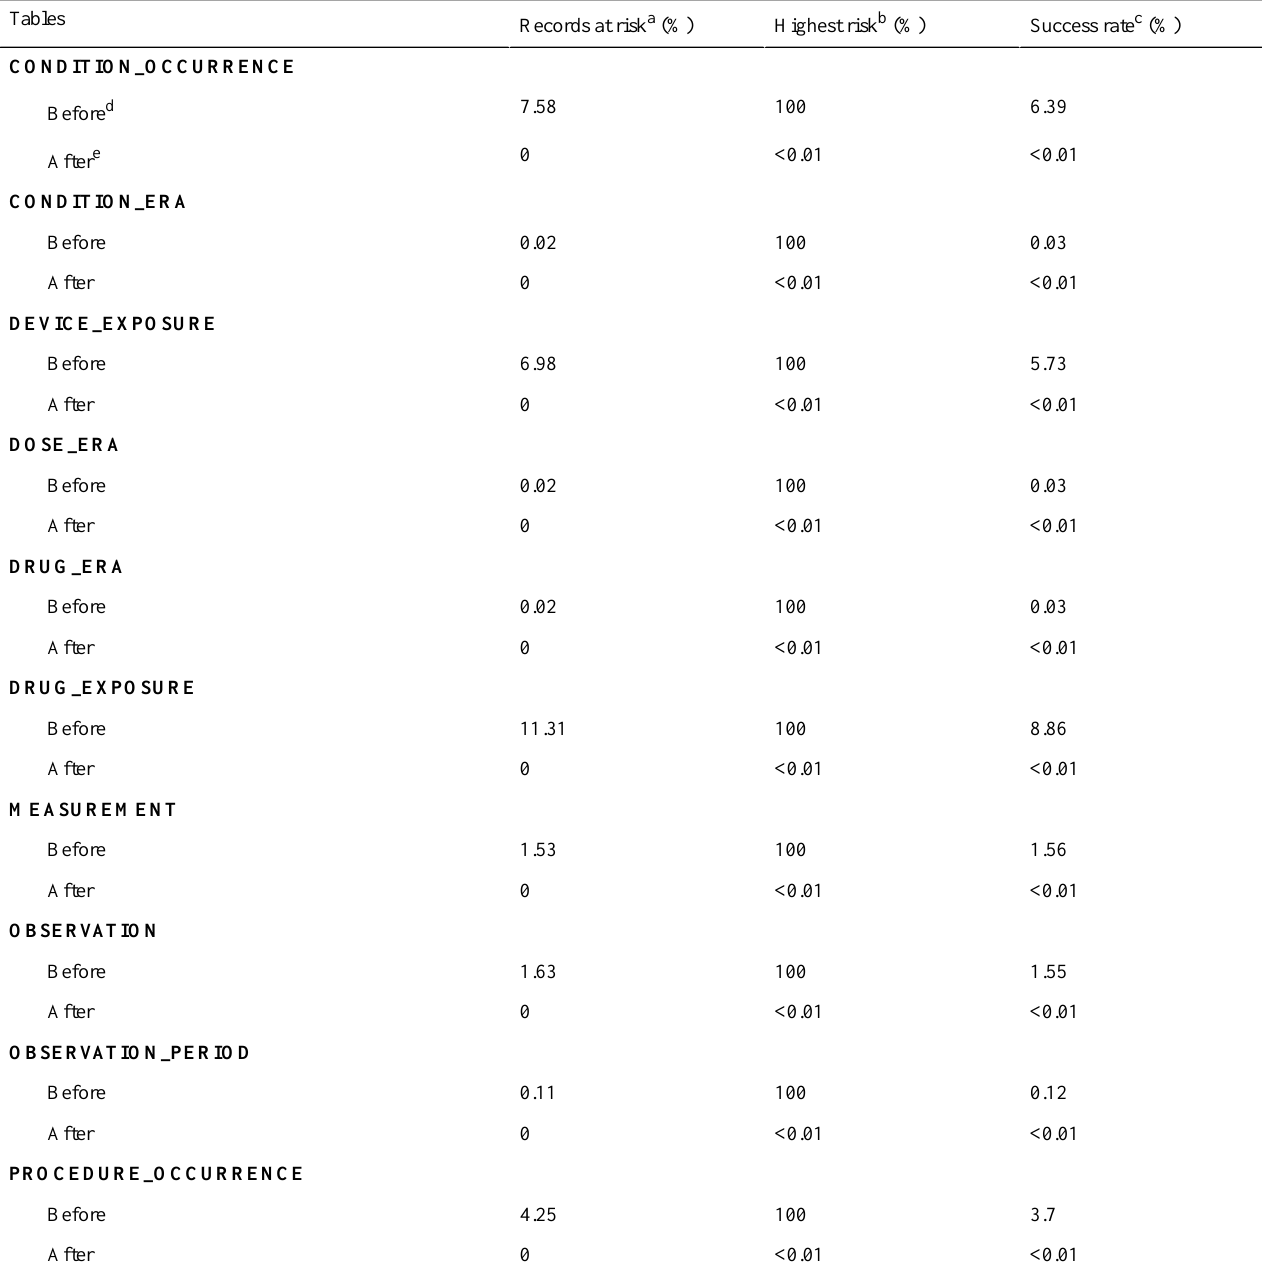
Table 5. Re-identification risks before and after source_value anonymization (t-closeness, t =